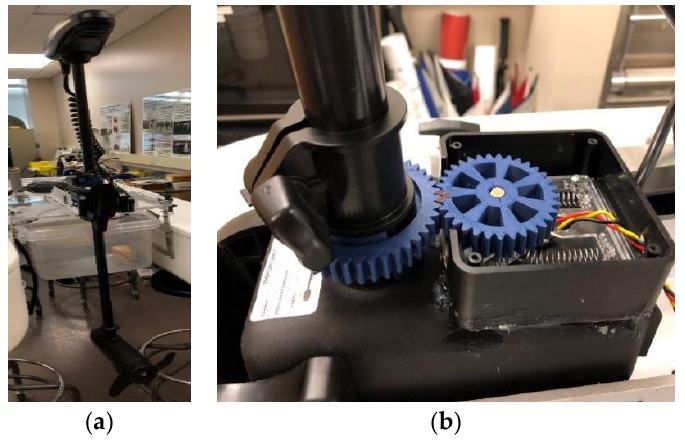
Figure 8. Propulsion and steering systems: ( a ) Minn Kota marine propulsion unit and ( b ) rotational potentiometer used for shaft position feedback.